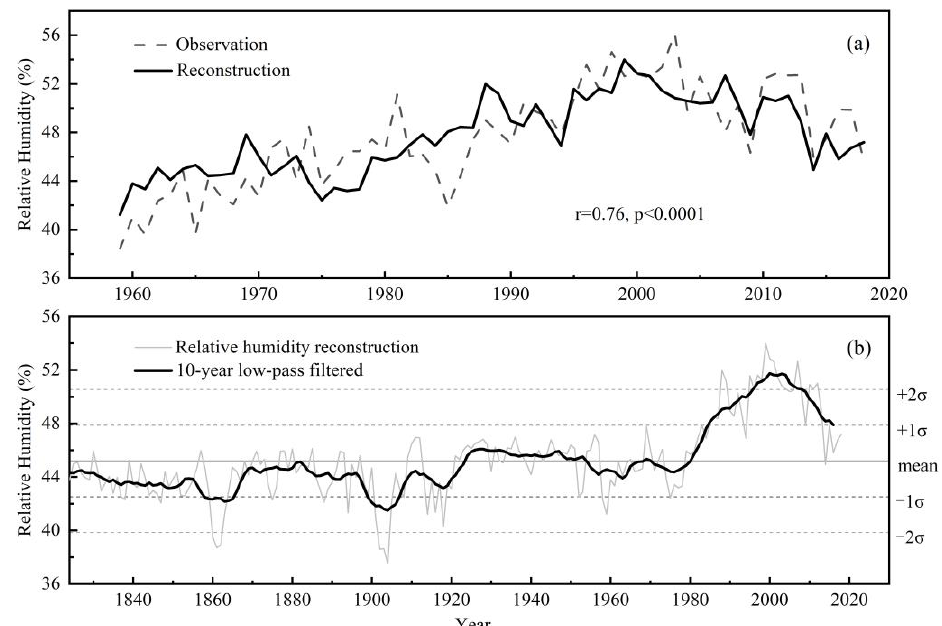
Figure 5. Relative humidity reconstruction on Alaer, Xinjiang, China. ( a ) A comparison of observed and reconstructed series of RH AS during the period 1959–2018. ( b ) Tree-ring reconstruction of the relative humidity drawn annually from 1824 to 2018 (thin line) and a low-pass filter with a 10-year loess filter for each calendar year (bold line).